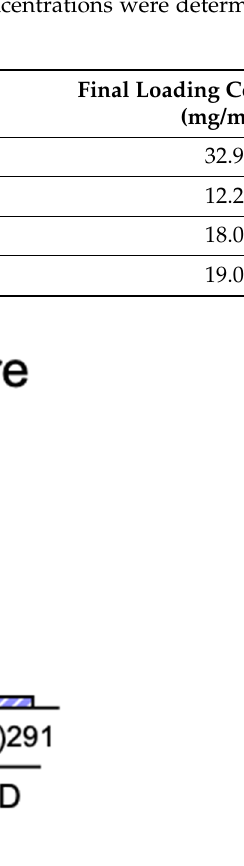
Figure 4. Incubation study of (+)SW033291-loaded β-CD MPs with Lad2 cells indicated sustained delivery in co-culture inhibits enzyme activity 72 h post-administration with similar efficacy as bolus SW033291 administration. (-) indicates the negative control group.